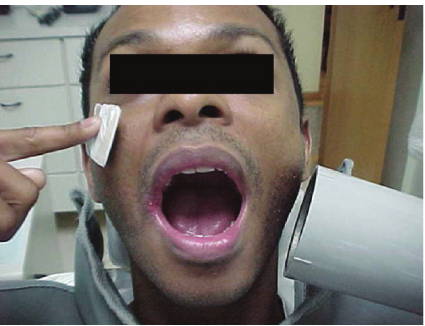
Figure 2: Extroral technique for final radiograph in root canal therapy of the maxillary